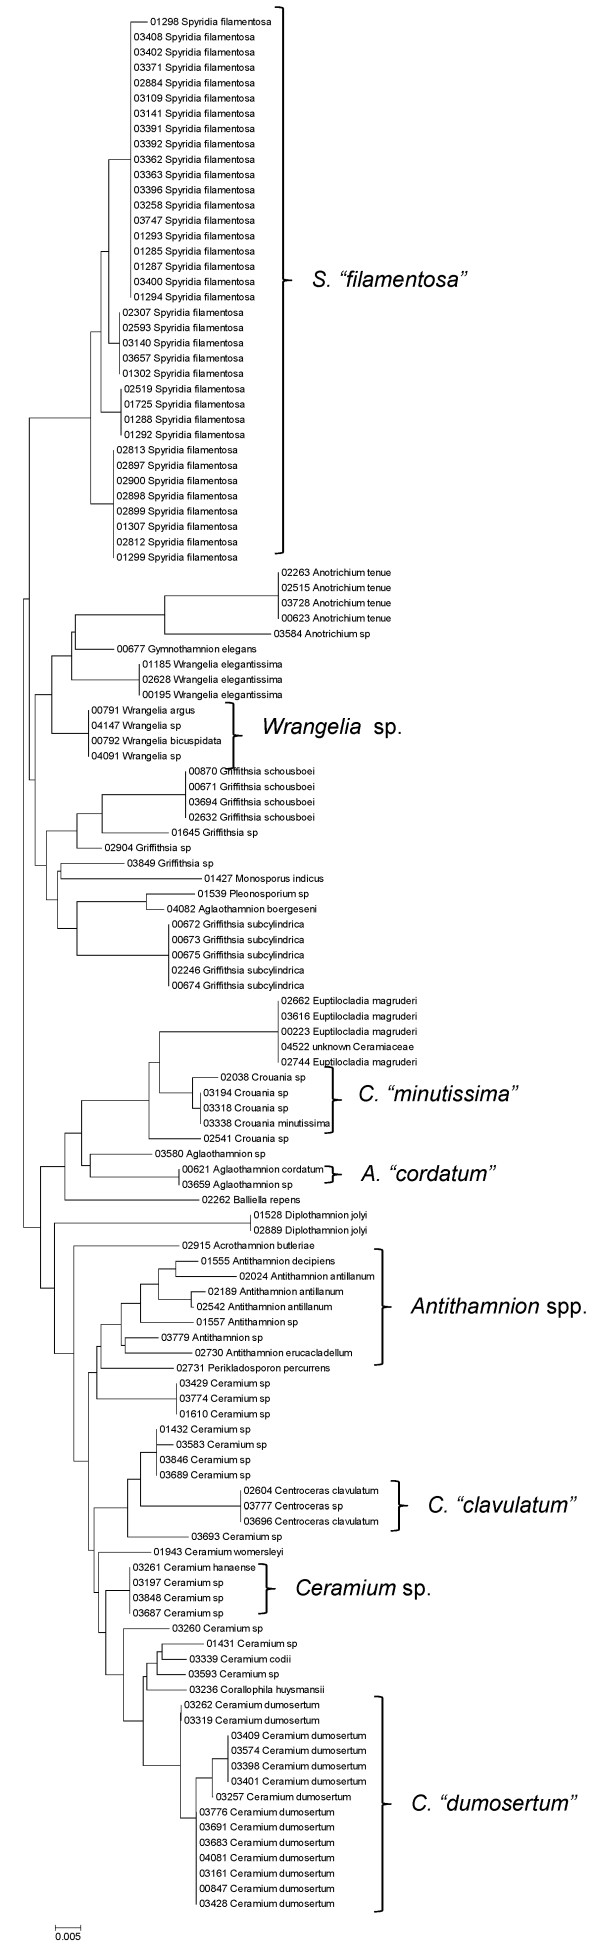
Neighbor-joining tree of UPA sequences of the families Callithamniaceae, Ceramiaceae, Spyridiaceae and Wrangeliaceae of the order Ceramiales. Sequence diversity based on the UPA plastid marker for surveyed Rhodophyta specimens belonging to the families Callithamniaceae, Ceramiaceae, Spyridiaceae and Wrangeliaceae of the order Ceramiales. Neighbor-joining tree is based on the Maximum Composite Likelihood nucleotide model in MEGA 4.0. Scale bar = substitutions per site.